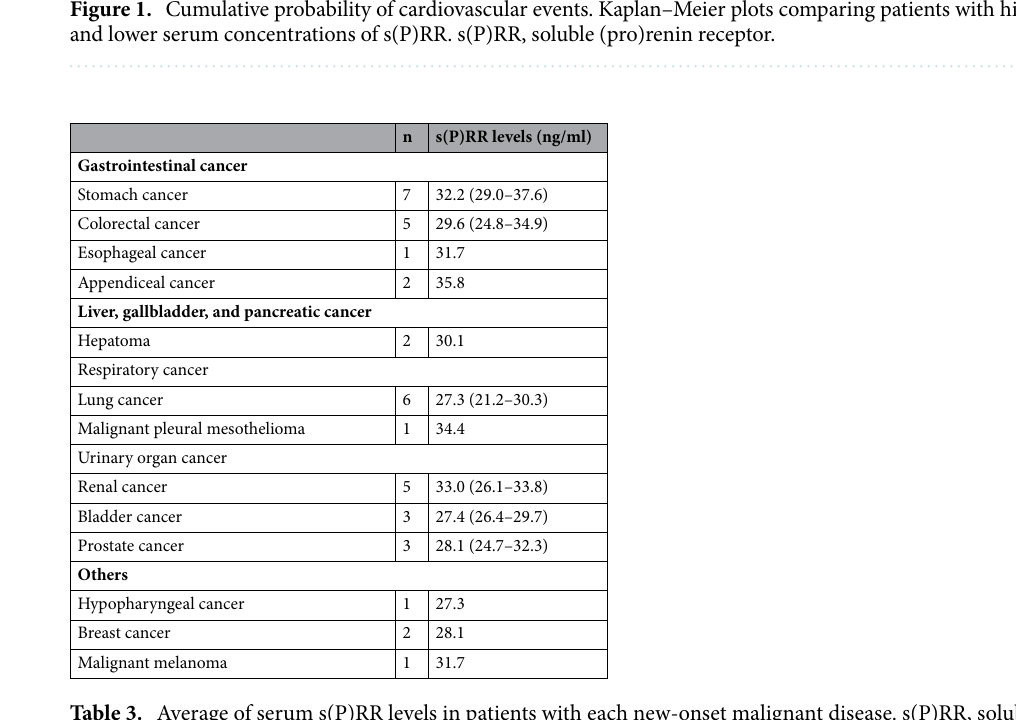
Table 3. Average of serum s(P)RR levels in patients with each new-onset malignant disease. s(P)RR, soluble (pro)renin